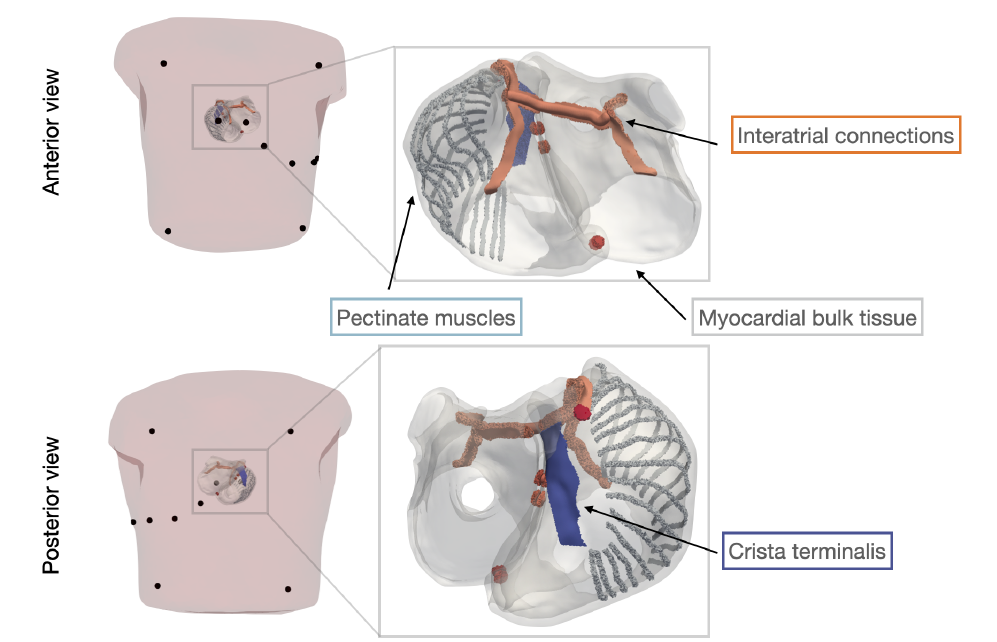
Figure 1. Overview of the atrial model used for the simulations, the top and bottom panels show the anterior and posterior view, respectively. The reference position of the atria within the torso as well as the electrode positions are visualized on the left side. On the right side, the atrial model is depicted with the tissue structures highlighted to which different conduction velocities were assigned.